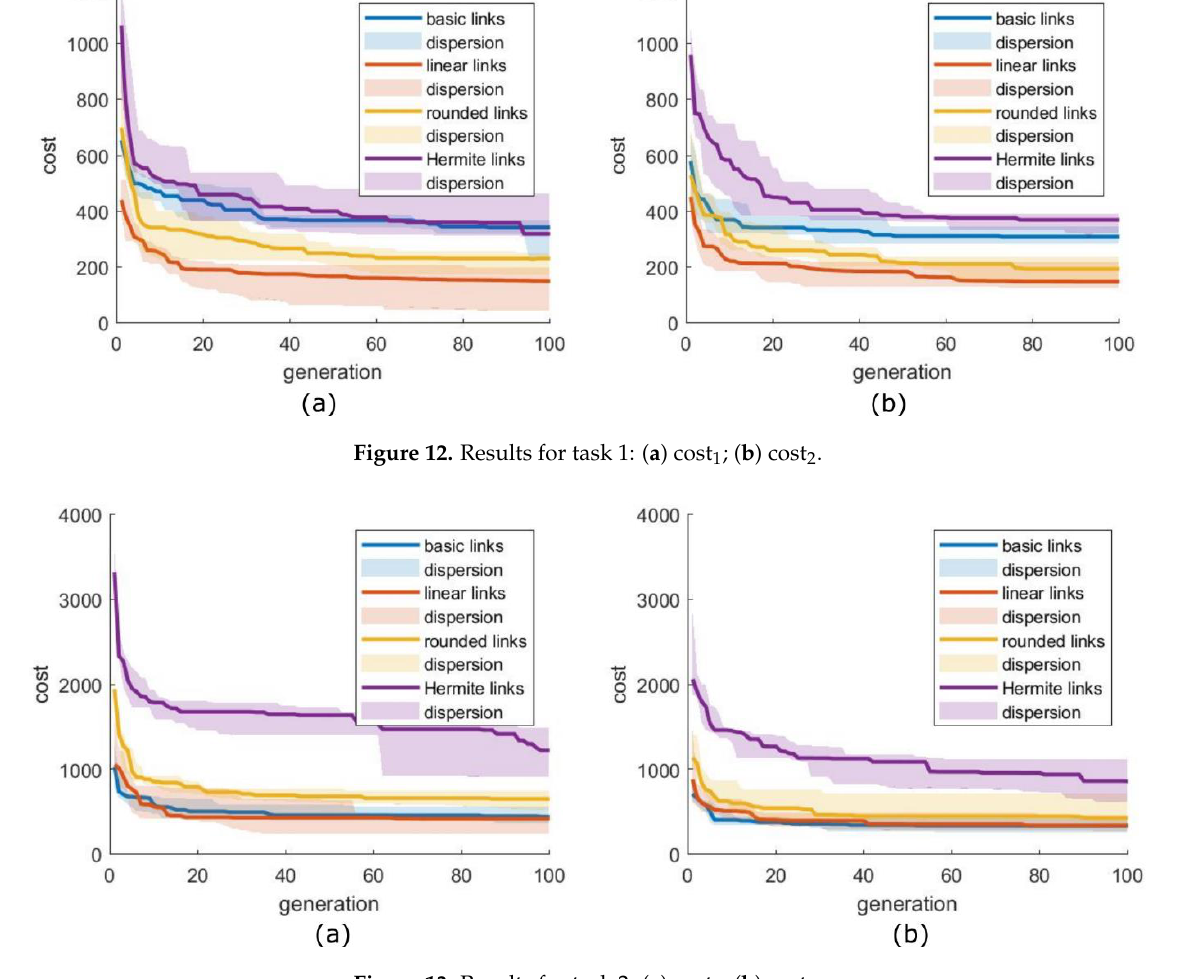
Figure 13. Results for task 2: ( a ) cost 1 ; ( b ) cost 2 .